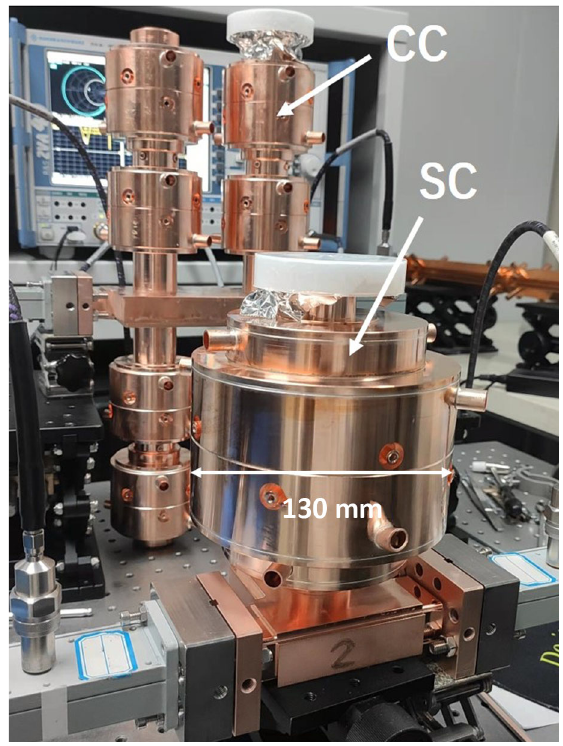
FIG. 10. Microwave measurement of the storage cavity during tuning with the correction cavity chain measured